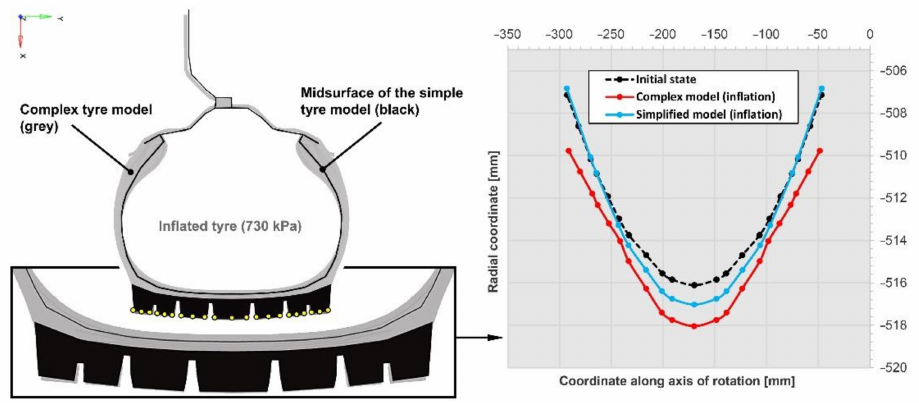
Figure 9. Comparison of deformation in the two types of finite element tyre models at 730 kPa pressure.